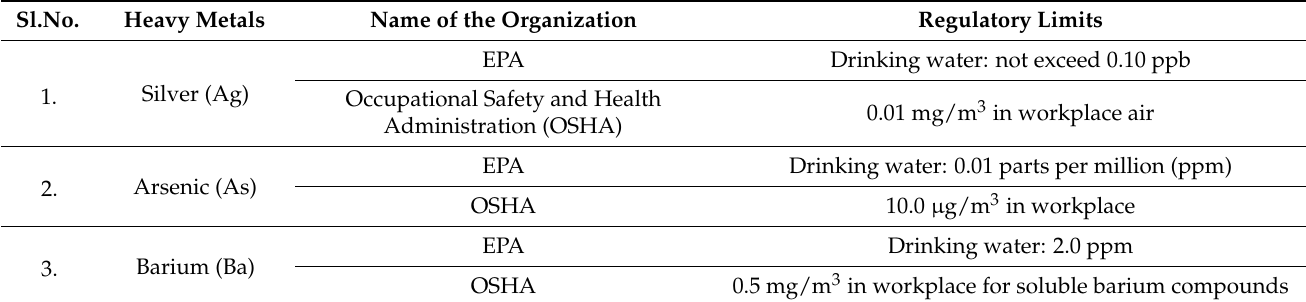
Table 1. Summary of regulatory limits of heavy metals